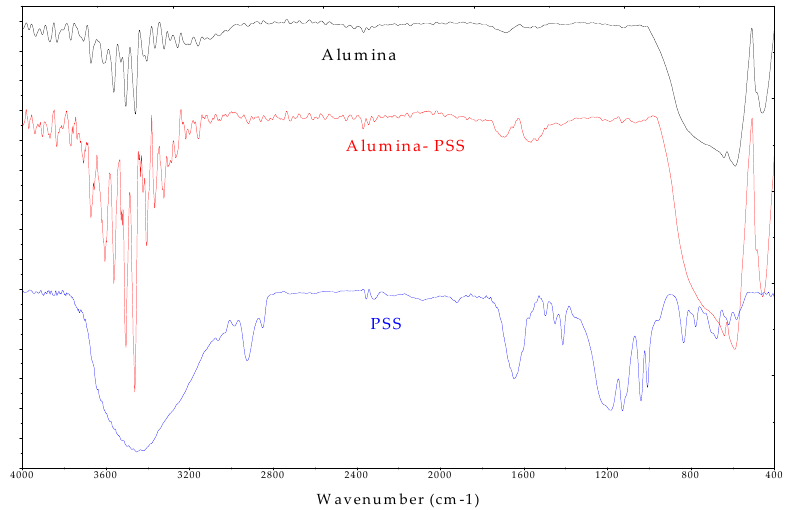
Figure 2. FT-IR spectra of alumina and alumina modified with PSS (alumina–PSS) and PSS. The results of adsorption isotherm and FT-IR spectra indicate that the PSS adsorption onto α -Al 2 O 3 surface achieved the maximum adsorption amount of 11 mg/g at 100-mM NaCl, contact time 120 min and pH 4, as shown in our previous publication [19]. The PMA was formed with the initial PSS concentration of 0.1 mg/mL.